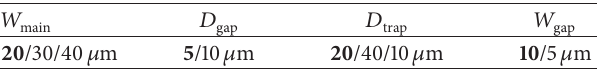
Table 1: Key geometry parameters with chosen values used in = numerical simulations. The default values are as follows: 𝑊 main = 5 𝜇 m, 𝐷 = 20𝜇 m, and 𝑊 = 10 𝜇 m, which were 20 𝜇 m, 𝐷 gap gap trap chosen based on estimated diameters of biological cells ( ∼ 15 𝜇 m). Theheightofthemainchannelis20 𝜇 mandtheheightofthecellular trapping site is 5 𝜇